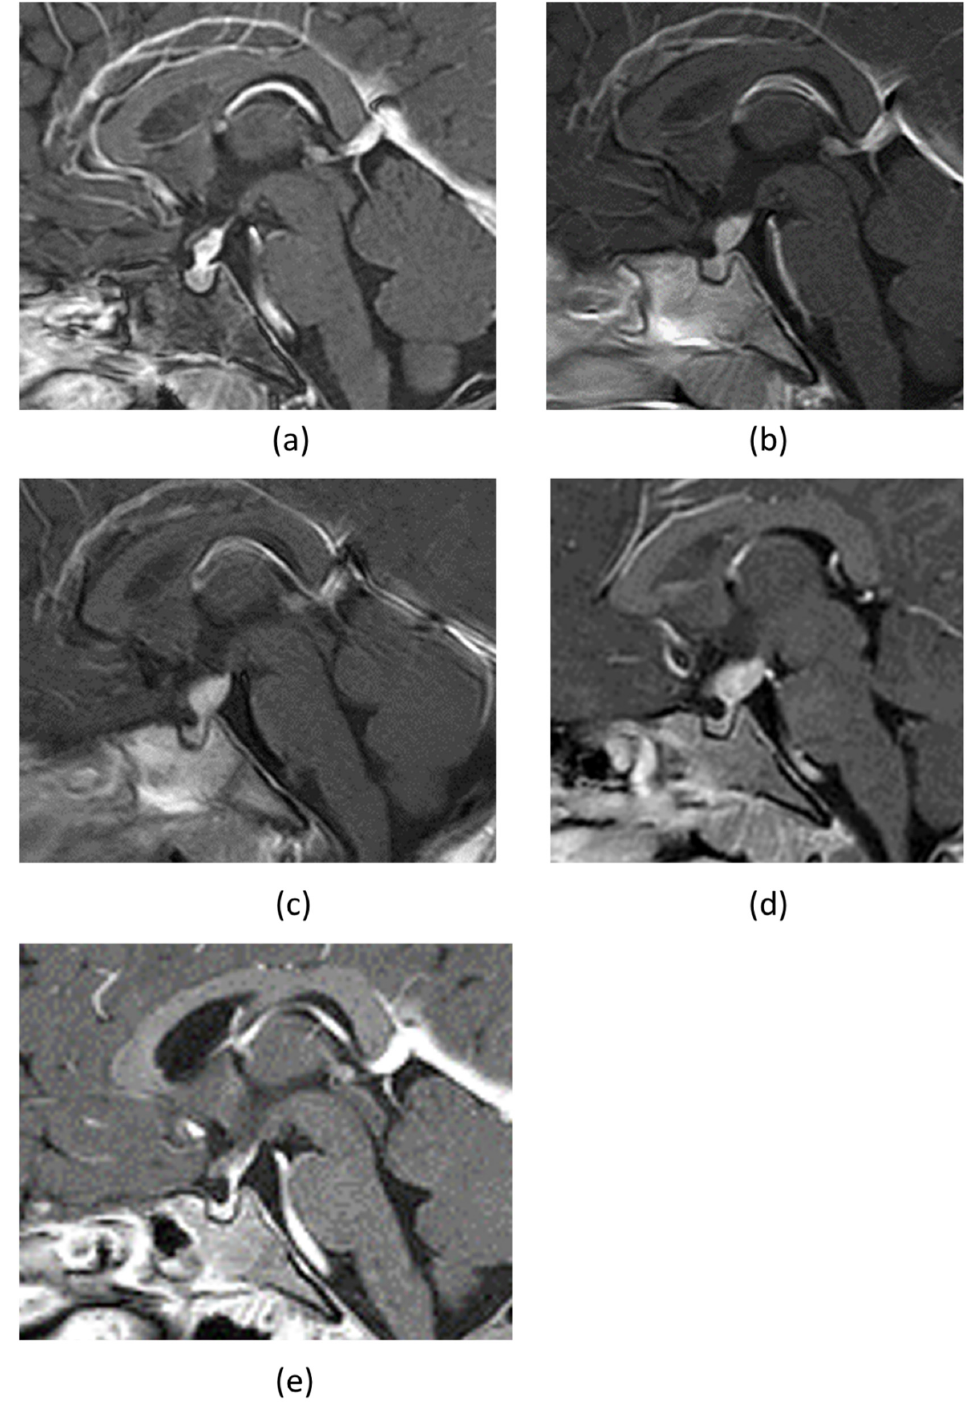
Figure 1. ( a ) The gadolinium-enhanced sagittal T1-weighted MRI of the brain at the time of admission, which showed pituitary stalk thickening and the loss of the physiological hypertense signal in the posterior pituitary gland. MRIs after three months ( b ), six months ( c ), and one year and three months ( d ), showed that the tumor mass was gradually increasing and seemingly moving posteriorly, reaching the area near the mamillary body. ( e ) MRIs after 6 courses of cladribine showed that the tumor tended to shrink.